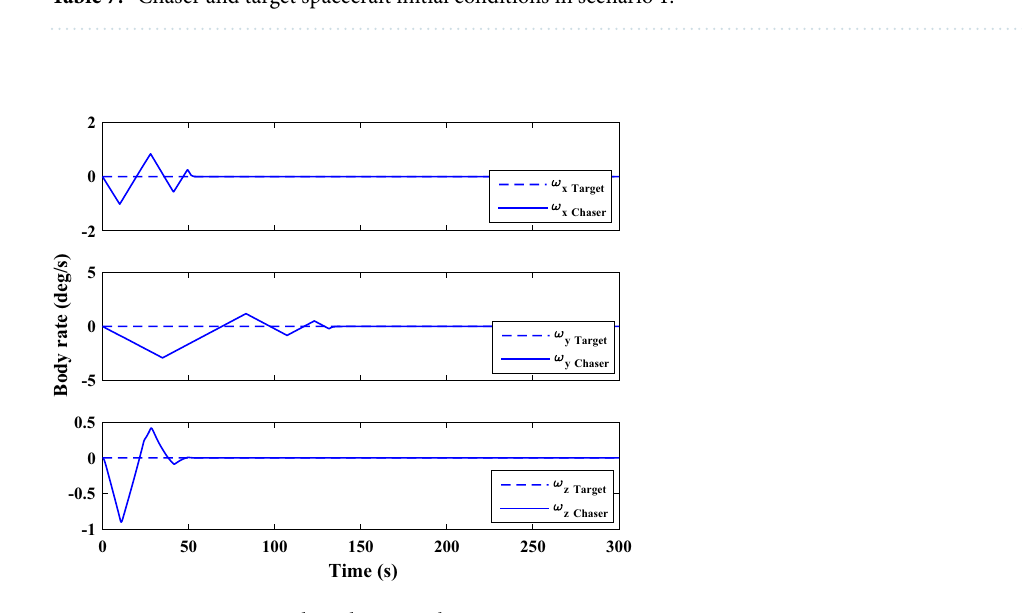
Figure 14. Scenario I: angular velocity tracking.